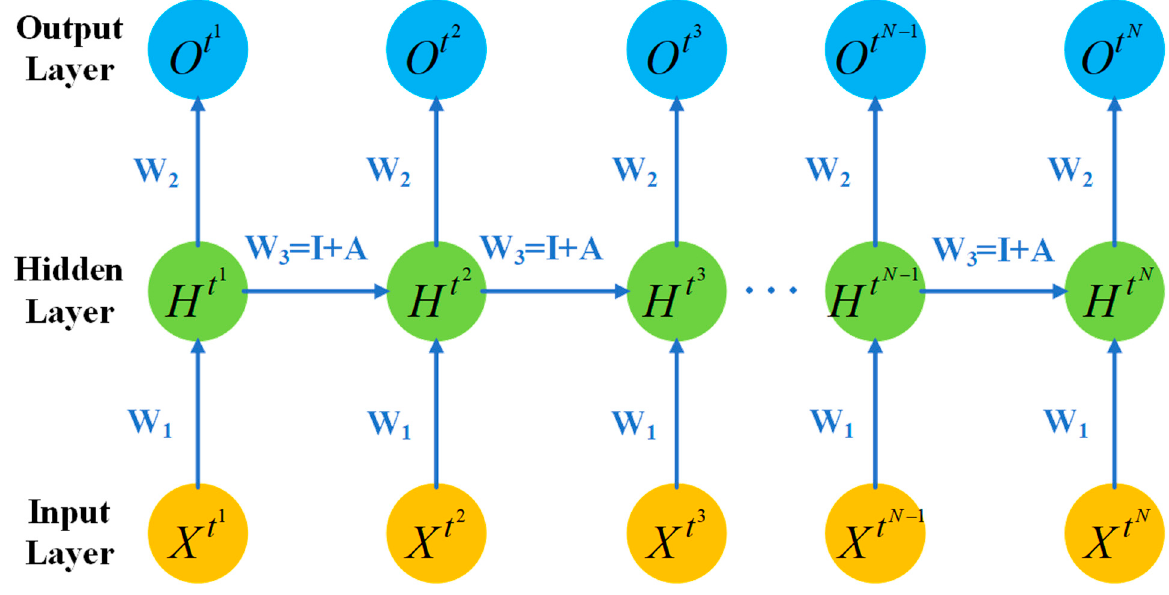
Figure 3. The weight initialization of Simple RNN.